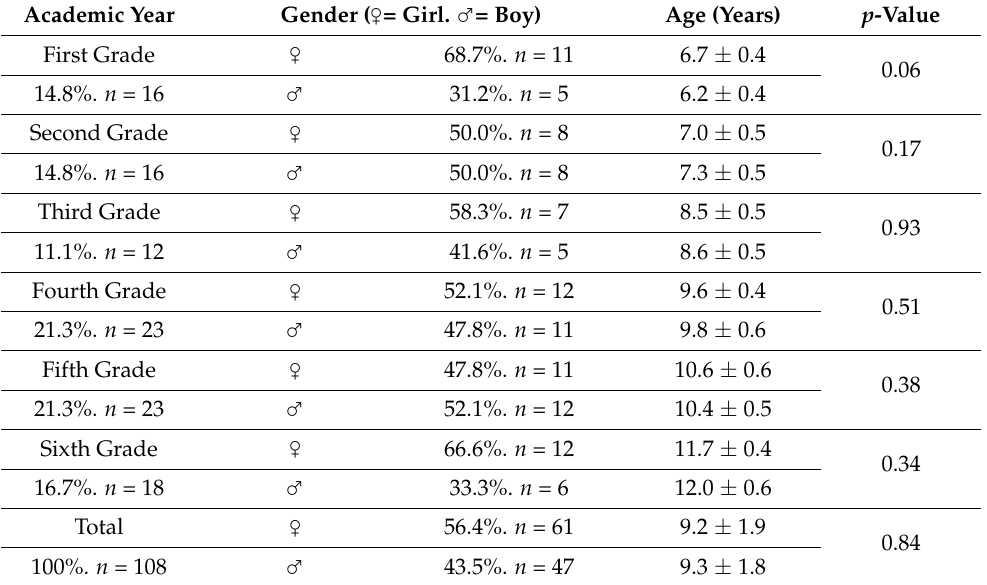
Table 2. General description of the sample by academic year and